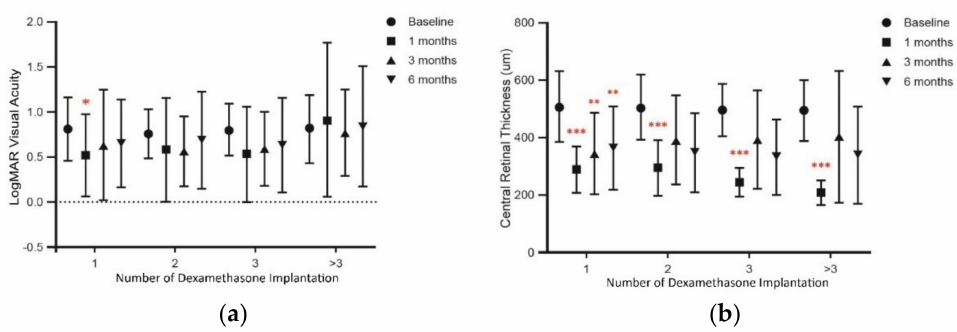
Figure 2. The change in ( a ) LogMAR visual acuity and ( b ) central retinal thickness from baseline after the intravitreal dexamethasone implantation based on the number of implantations at different time points. Values represent mean ± SD. p < 0.05 were considered statistically different. * p < 0.05, ** p < 0.01, *** p < 0.001.